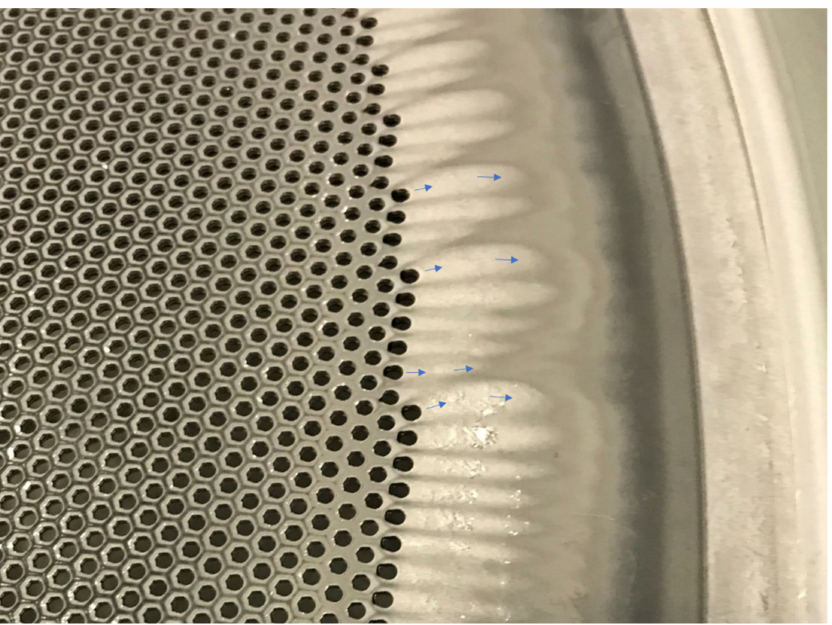
Figure 17. Photo of grid periphery showing the erosion-deposition pattern. Net erosion emanates radially from the peripheral set of holes, with directionality influenced by the hole